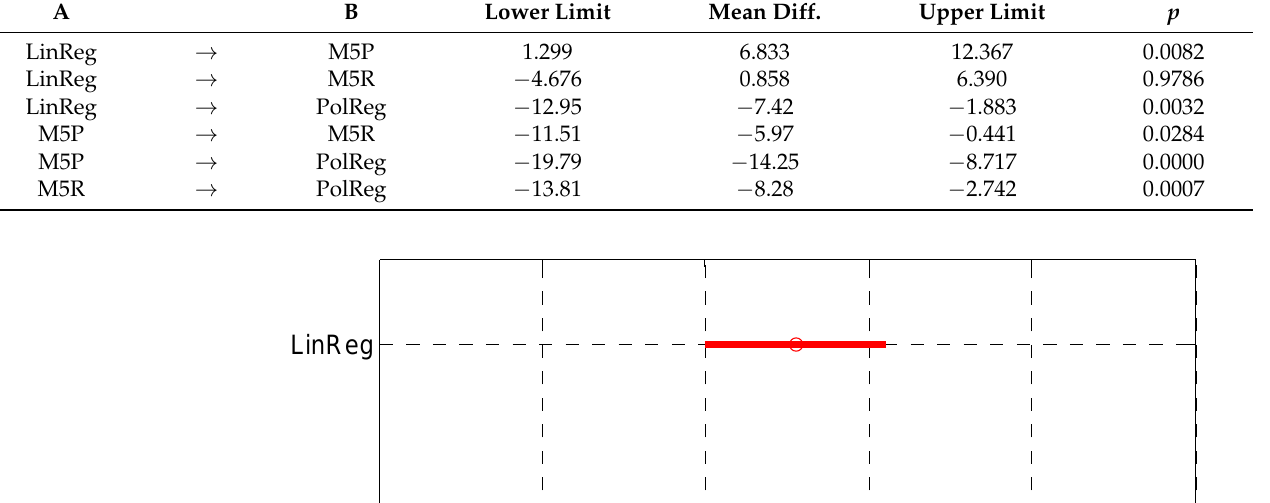
Table 6. Pairwise comparison of performance measurements from the ROPE process. A p -value smaller than 0.05 indicates a significant difference. The algebraic sign of the mean value allows for the decision of which model is better.